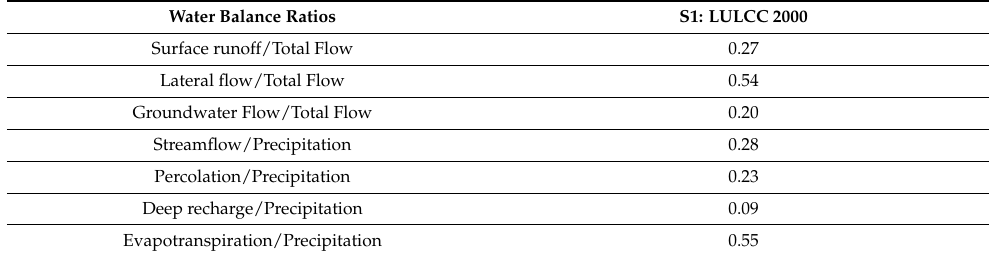
Table 8. Water balance ratios simulated by SWAT between 2000 and 2021 with current land use of the Paraopeba River